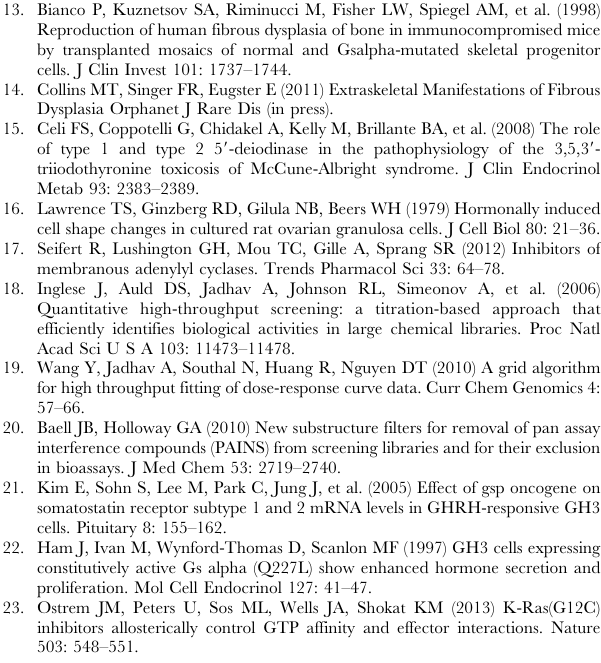
tachykinin receptor antagonist is shown. Figure S10 Forskolin dose response. Six different cell lines stably transfected with Gs a [wild type (WT9), R201C mutants (C6, C7), and R201H mutants (H25, H37, H40)] were tested for a cAMP response to forskolin. cAMP was measured in a HTRF assay (see Methods). The lower the 665/590 ratio, the higher the cAMP concentration. The robust response of WT9 cells indicted that when treated with a suboptimal dose of forskolin it was a suitable line for testing the ability of compounds to inhibit G s a activity. Table S1 LOPAC Screen Assay Protocol.